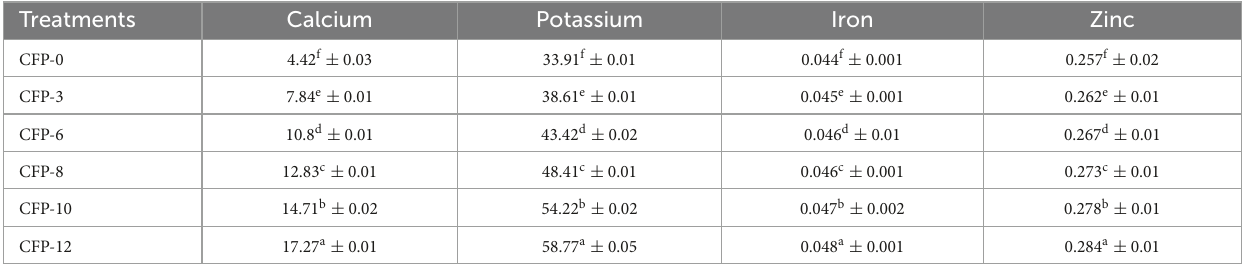
TABLE 4 Mineral contents (mg/100 g) of cookies fortified with pomegranate peel (PP) powder. Treatments